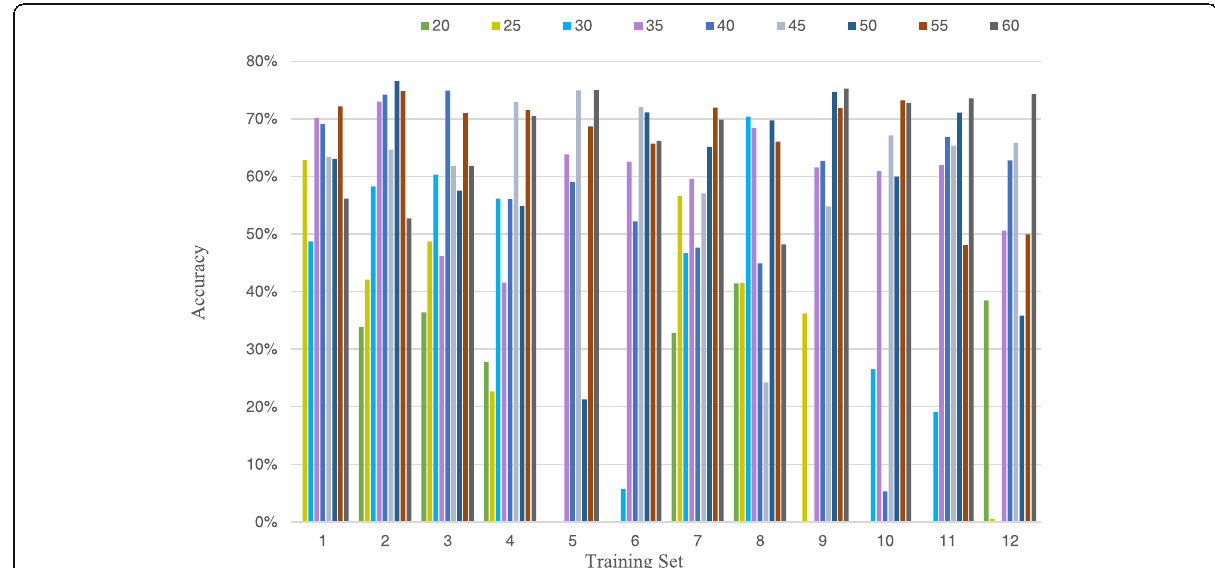
Fig. 4 The accuracy in the training process with different dimensions of compressed feature for the 12